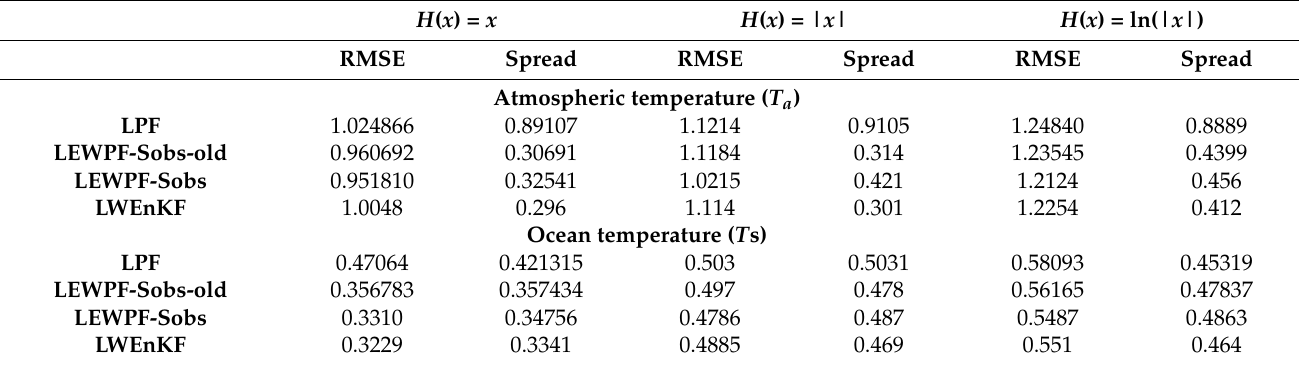
Table 2. The LEWPF-Sobs, LPF, LWEnKF and LEWPF-Sobs-old annual averaged RMSE and Spread of particles for